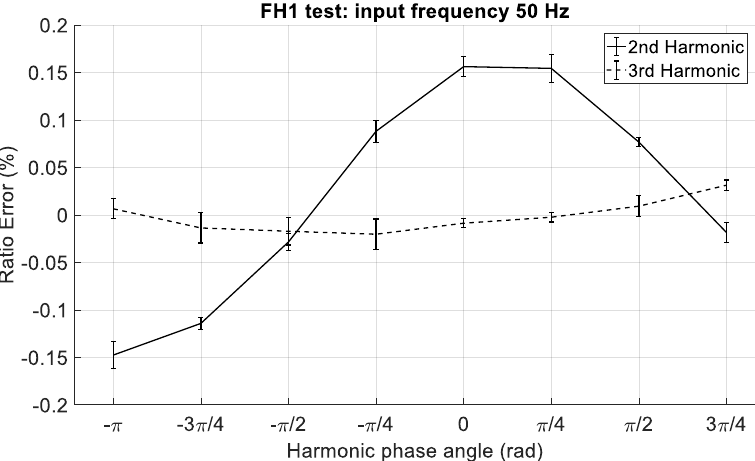
Figure 16. Ratio error in the FH1 tests; waveforms have two tones, fundamental tone has amplitude